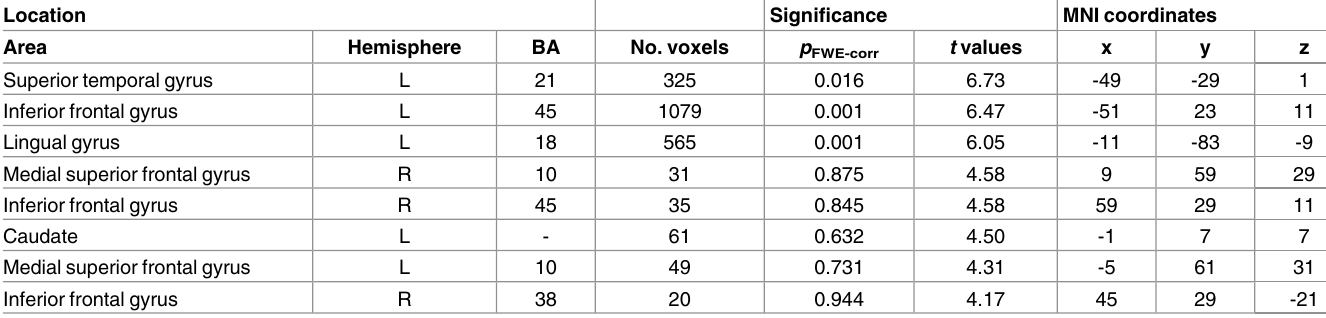
Table 3. Whole-Brain Activation for the Irony > Literal Comparison.